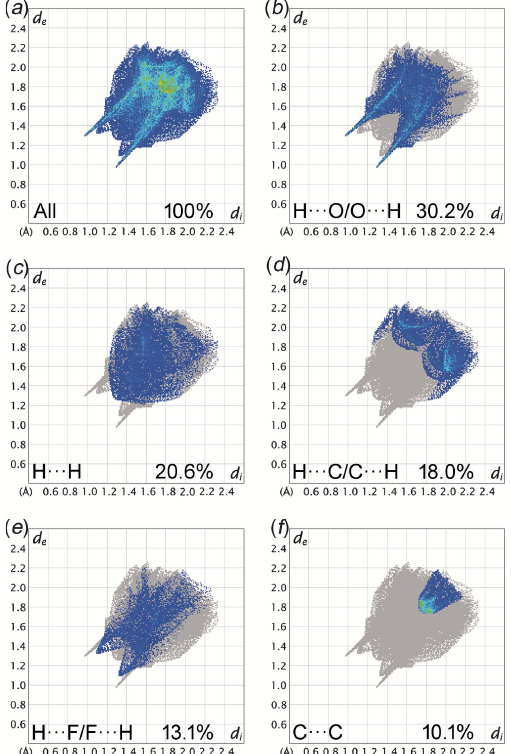
Figure 5 The two-dimensional fingerprint plots of the title compound for different intermolecular contacts and their percentage contributions to the Hirshfeld surface. d i and d e are the distances from the Hirshfeld surface to the nearest atom interior and exterior, respectively, to the